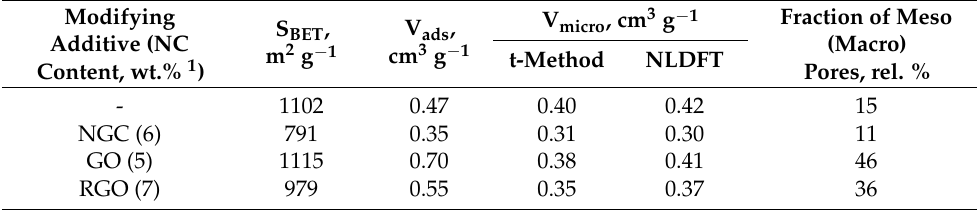
Table 1. Pore structure parameters of the carbon material and PCCNC based on